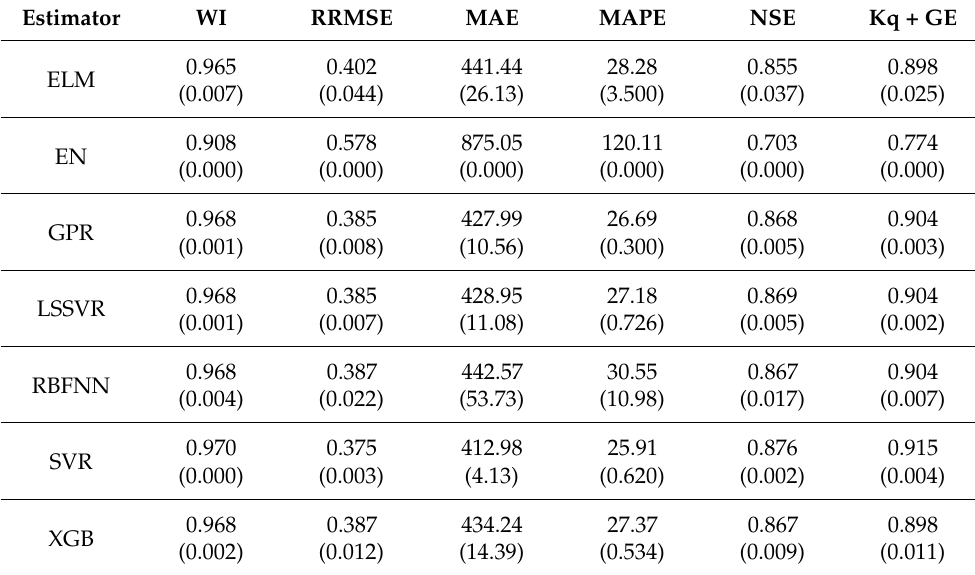
Table 7. Model results for Case 1.